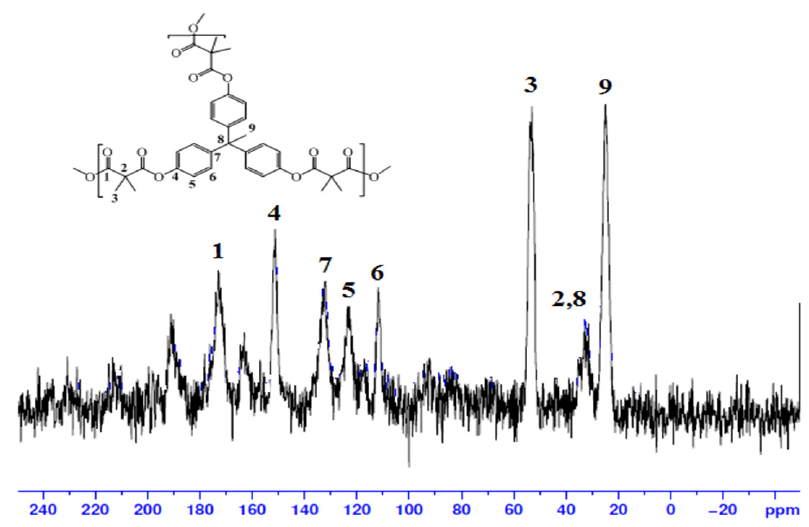
Figure 3. Solid NMR spectrum of the hyperbranched polyester.